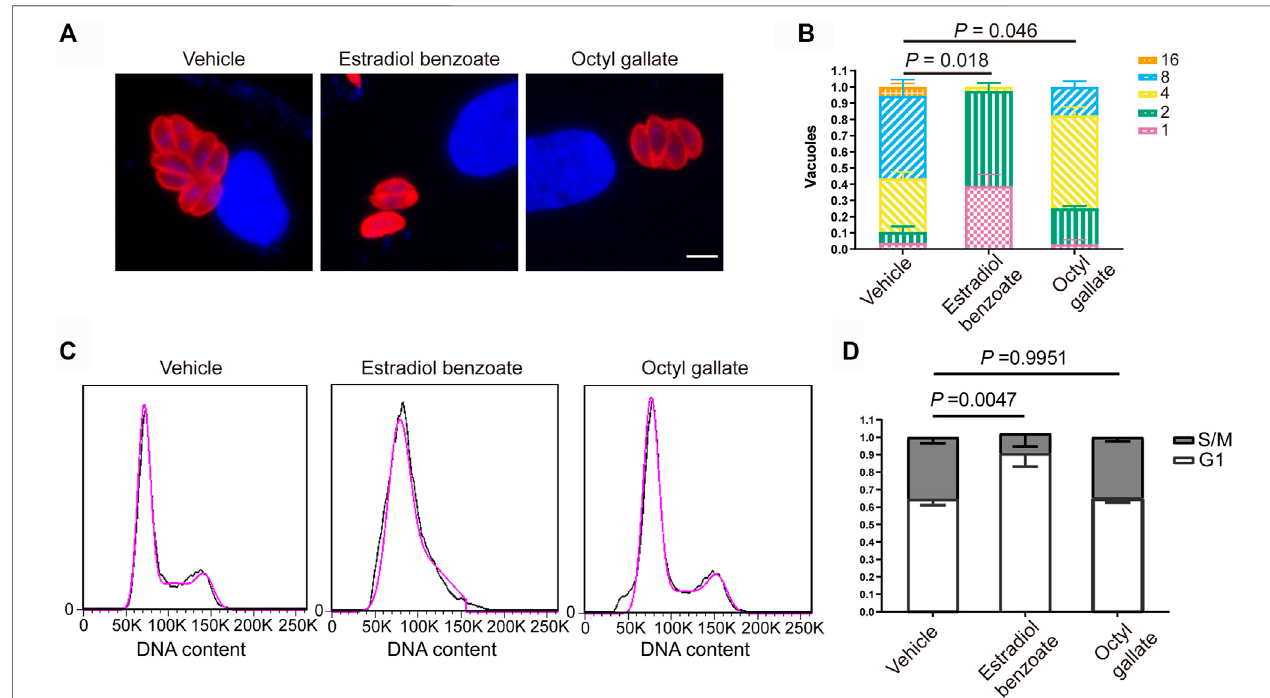
FIGURE 5 | Inhibitory effects of estradiol benzoate and octyl gallate on parasite intracellular replication. (A) HFFs infected with RH-2F were treated with estradiol benzoate, octyl gallate, or DMSO for 24 h. The cells were fi xed and detected using IFA. Immuno fl uorescence micrographs of intracellular parasites are shown. (B) The number of parasites per vacuole were counted. The percentage of vacuoles containing different numbers of parasites was shown as the mean ± SD from one experimentrepresentativeofthreeindependentexperiments.Scale = 5 μ m. (C) Flowcytometricanalysisoftheeffectsofestradiolbenzoateandoctylgallateoncell cycle progression. Propidium iodide (PI) staining was used to measure the DNA contents. (D) The percentage of parasites in the S/M and G1 phases of the cell cycle.